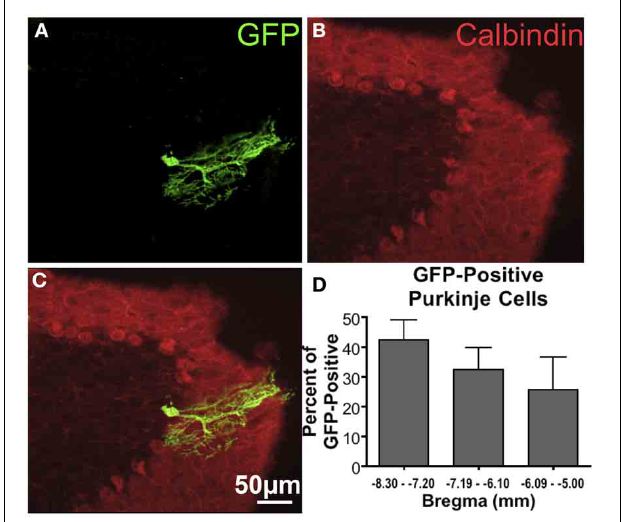
FIGURE 3 | GFP-ir in Purkinje cells of the cerebellum. (A) GFP-ir, showing one labeled cell. (B) Calbindin-ir illustrating the difference in morphology between the molecular, Purkinje, and granule cell layers of the cerebellum. (C) Overlay of images in (A) and (B) illustrating that this GFP-positive neuron is a Purkinje cell. (D) A graph showing the fraction of GFP-positive Purkinje cells found at different distances from Bregma indicates a trend toward decreasing transduction of Purkinje cells in more rostral portions of cerebellum. Only GFP-positive Purkinje cells were counted. The graph represents counted cells for each range of distances from Bregma as percent of all GFP-positive Purkinje cells (78 total cells counted). There was no significant difference in the number of GFP-positive Purkinje cells found in each range of distances from Bregma (One-Way ANOVA, P > 0 . 05, n = 4).